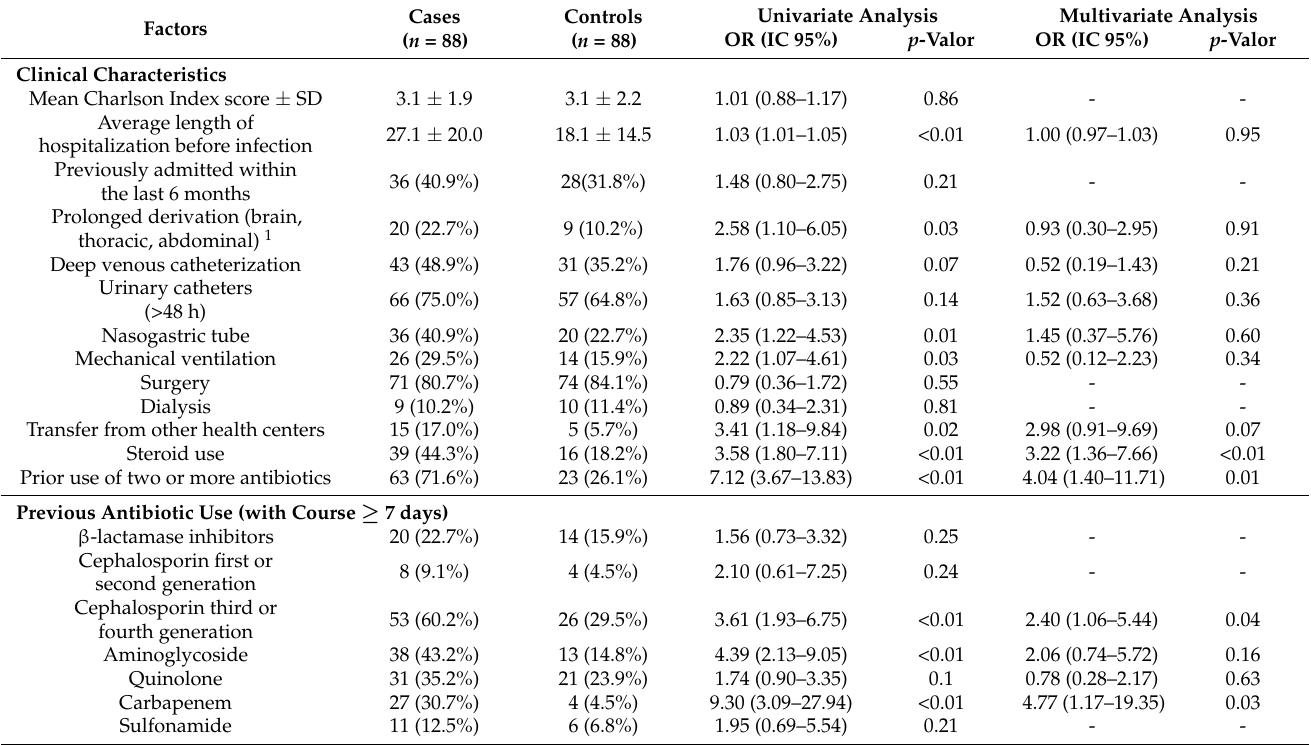
Table 4. Risk factors associated with CRE and CSE